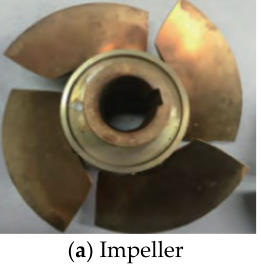
Figure 4. Physical diagram of the pump hydraulic model.